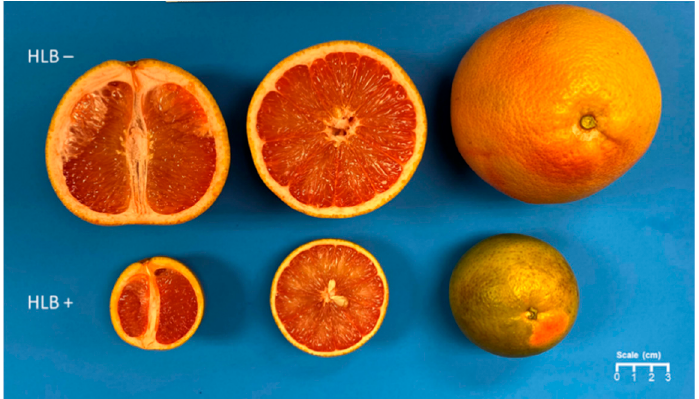
Figure 2. Fruit appearance of ‘Ray Ruby’ grapefruit of healthy (HLB − ) and HLB-affected (HLB+) fruits (2021).